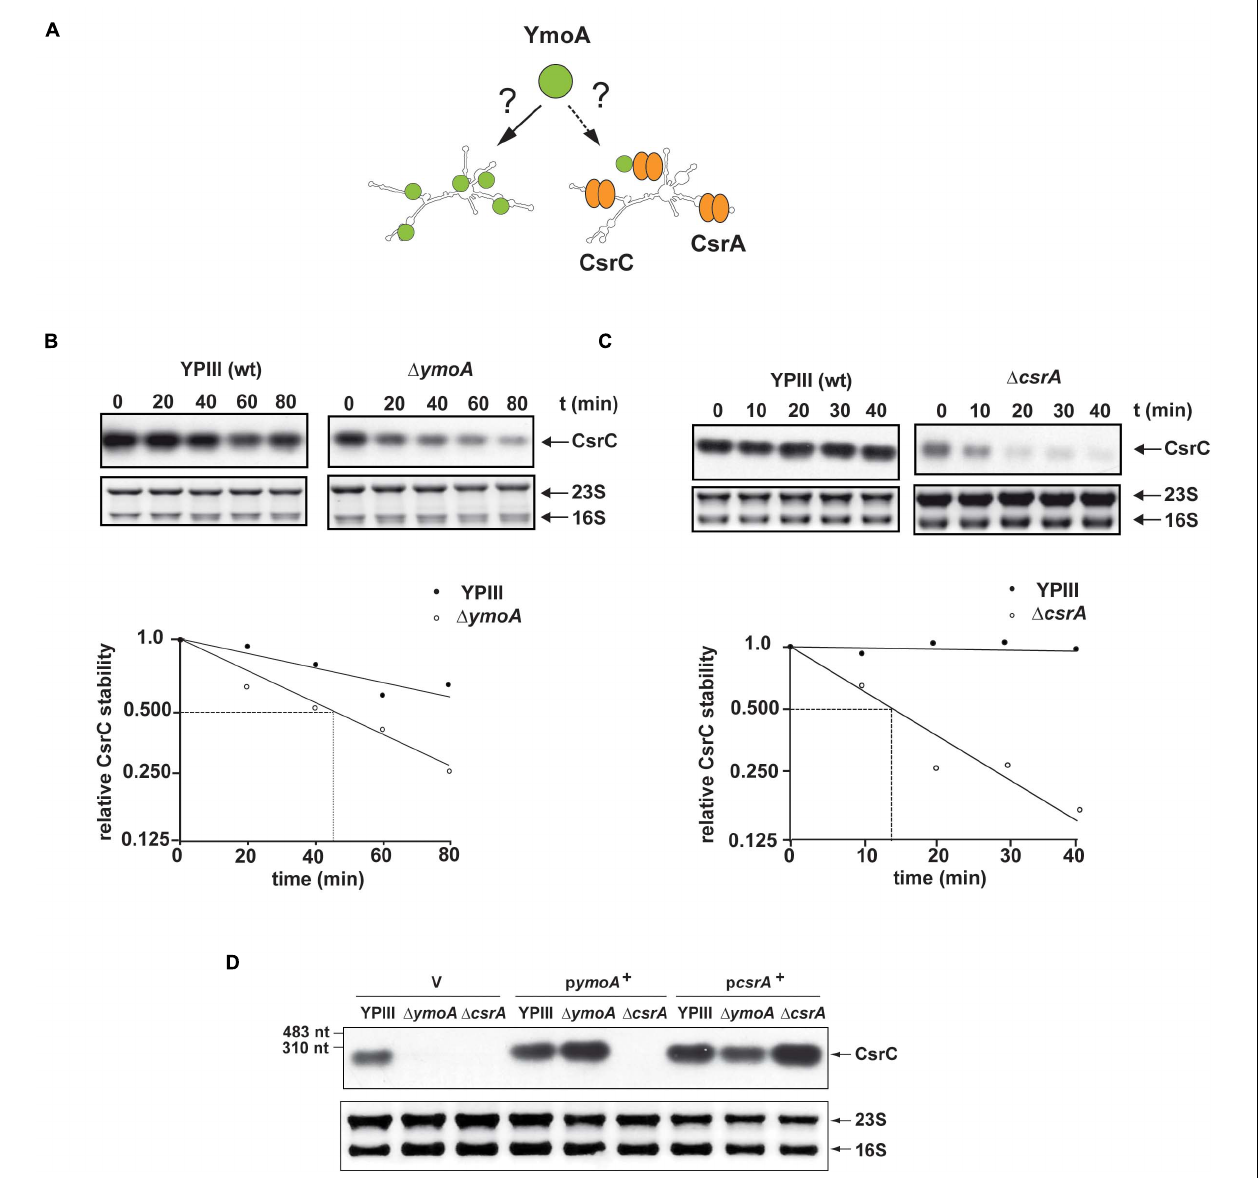
FIGURE 5 | YmoA and CsrA increase the stability of the CsrC RNA. (A) Model for YmoA-dependent CsrC stabilization. (B,C) The stability of the CsrC RNA expressed under the control of the tet promoter was compared between Y. pseudotuberculosis strain YPIII (wild-type) and YP50 ( (cid:49) ymoA ) (B) or YP53 ( (cid:49) csrA ) (C) and CsrC RNA stability was analyzed over time by Northern blotting with a CsrC- specific probe. A representative Northern blot of three independent experiments is shown in the upper panel. 16S and 23S rRNA were used as loading controls. The band corresponding to the CsrC transcript was quantified using the BioRAD Image LabTM Software and was plotted versus time of extraction (in minutes) to calculate the half-life of the sRNA indicated by dotted lines (lower panel). (D) Y. pseudotuberculosis strains YPIII, YP50 ( (cid:49) ymoA ), and YP53 ( (cid:49) csrA ) harboring vector pHSG576 (V), a ymoA + (pKB4) or csrA + derivative (pKB60) were cultivated overnight in LB medium at 25 ◦ C. Total RNA of the strains was extracted, separated on agarose gels and a CsrC-specific probe was used to detect the CsrC ncRNA by Northern blotting. Used RNA marker is marked on the left. The 16S and 23S rRNAs are shown as RNA loading